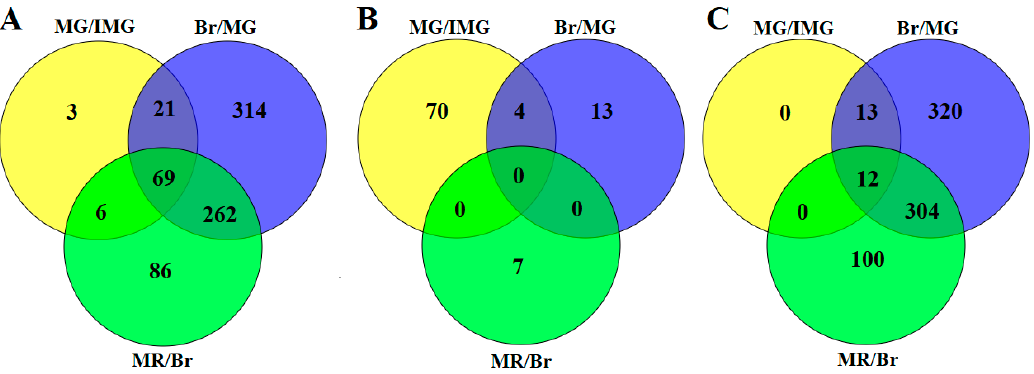
Figure 2. Overlap of the differentially expressed phosphoproteins (DEPPs) in Venn diagrams with different comparisons. ( A ) Total DEPPs; ( B ) upregulated DEPPs; ( C ) downregulated DEPPs.